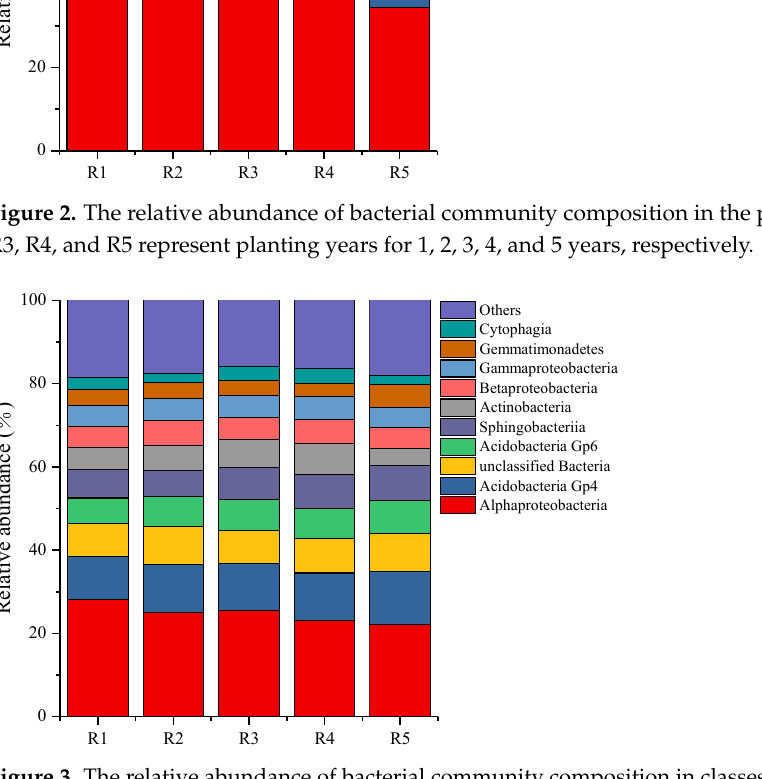
Figure 1. Venn diagram of bacterial OTUs for the soil samples under continuous cropping of indus- trial hemp. R1, R2, R3, R4, and R5 represent planting years for 1, 2, 3, 4, and 5 years, respectively. At the bacterial phylum level (Figure 2), the dominant phyla of all samples were Pro- teobacteria (34.47–39.81%), Acidobacteria (20.34–25.58%), Bacteroidetes (8.37–12.87%), Actinobacteria (4.18–7.77%), and Gemmatimonadetes (3.04–5.53%). Among them, with the increase of continuous cropping years, the relative abundance of Proteobacteria and Actinobacteria decreased gradually, while the relative abundance of Acidobacteria, Bac- teroidetes, and Gemmatimonadetes increased gradually.